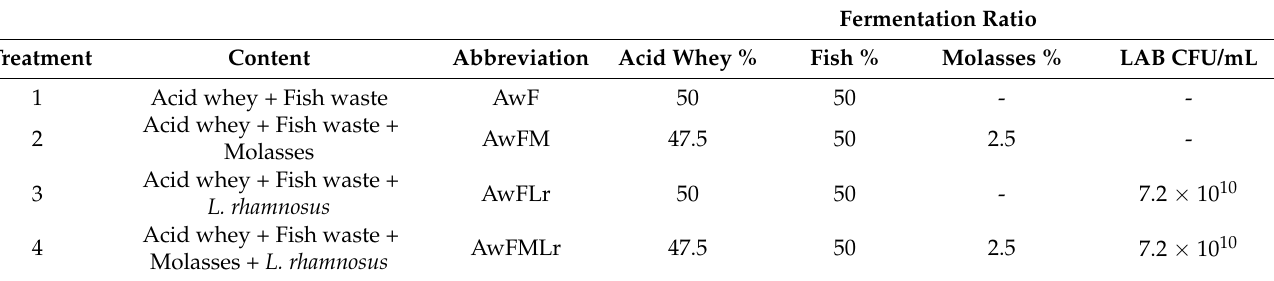
Table 1. Experimental